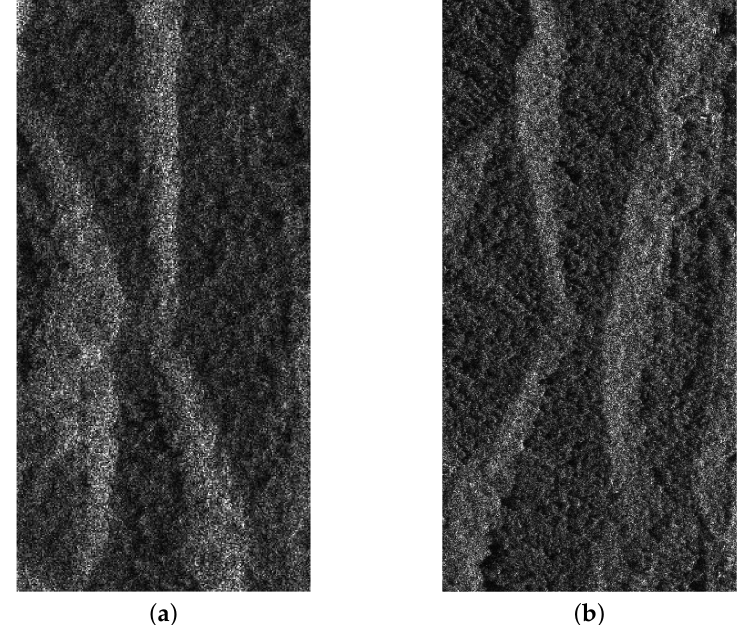
Figure 12. The mountainous area of ( a ) the ascending orbit image GF0719 and ( b ) the descending orbit image